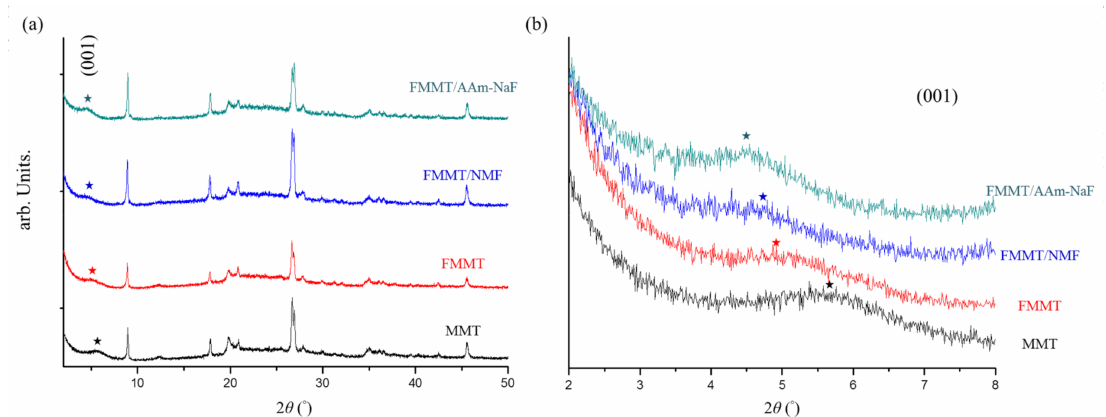
Figure 1. ( a ) XRD patterns of MMT, FMMT, FMMT-NMF, and FMMT-AAm-NaF from 2 ◦ to 50 ◦ ; ( b ) low-angle XRD patterns (2 ◦ –8 ◦ ) of MMT, FMMT, FMMT-NMF, and FMMT-AAm-NaF.